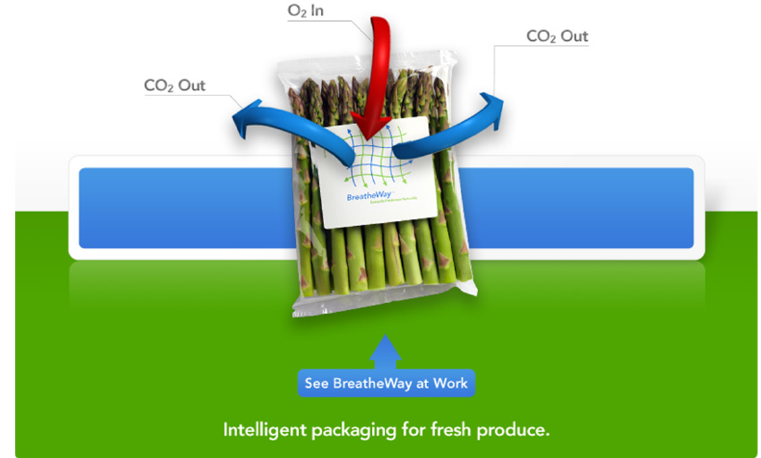
Figure 5. Breathable films and packaging (Reprinted courtesy of Breathway Corp).